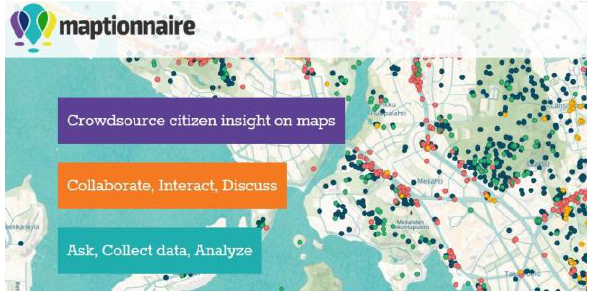
Figure 1. VGI platform